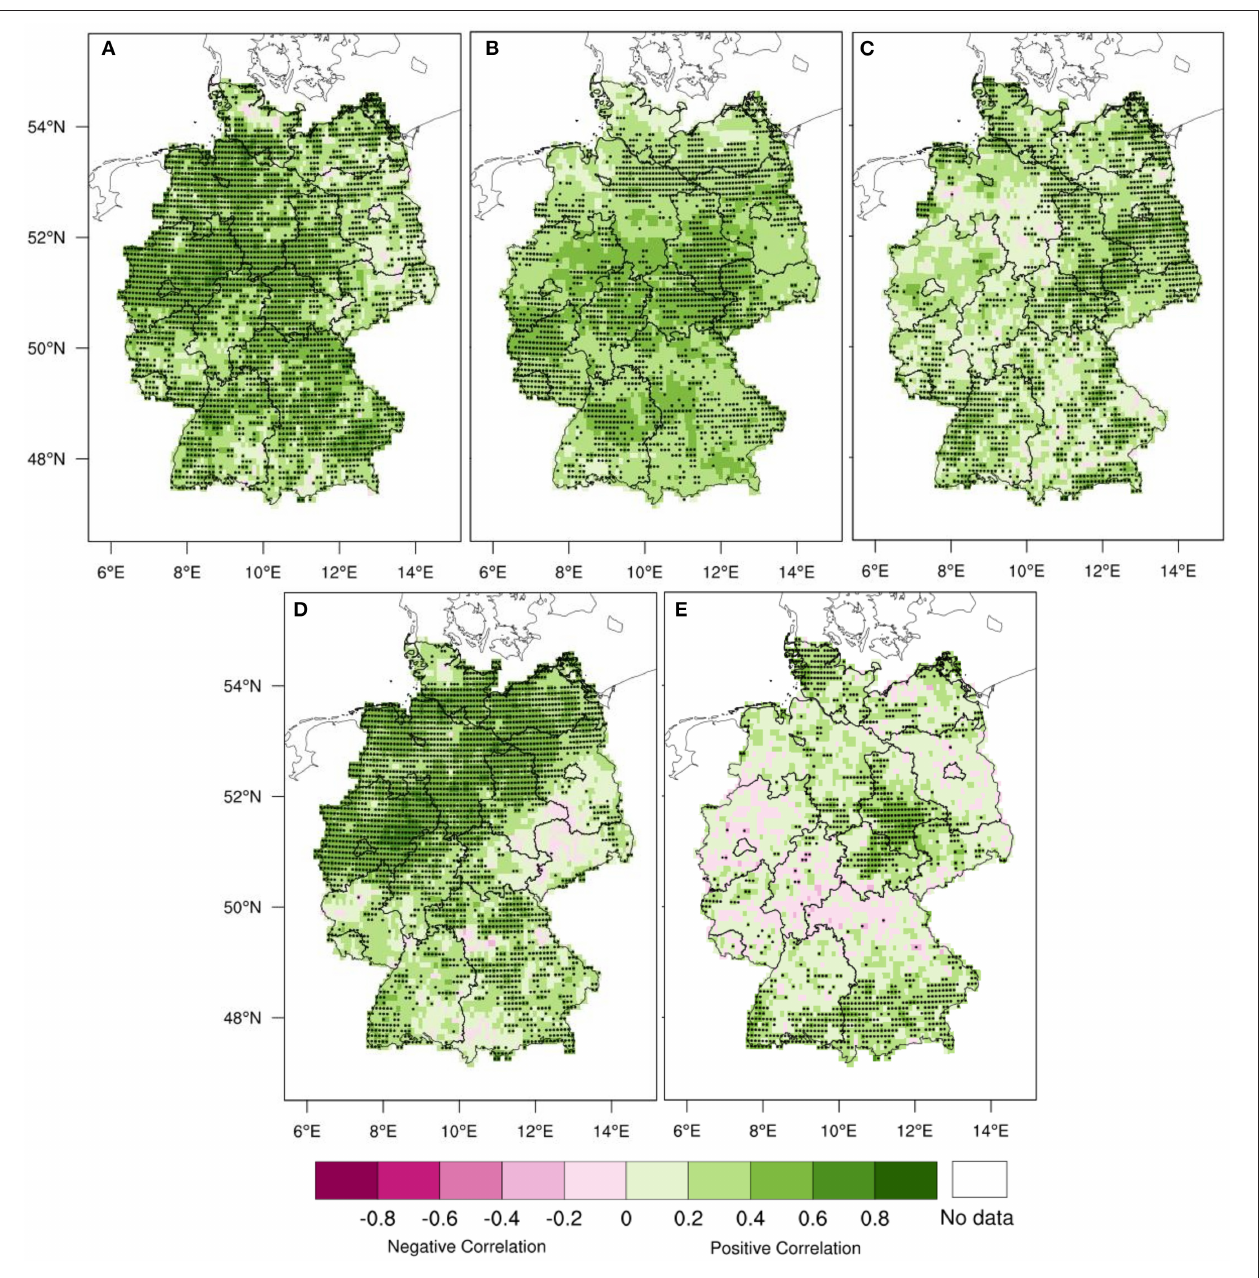
FIGURE 4 | Decadal prediction skill for 3-year SPI of January–December (A) , February–April (B) , May–July (C) , August–October (D) and November–January means (E) for forecast years 1–3 in the evaluation period 1962–2020 (1962–2019 for November–January): (Anomaly) correlation coefficient between EPISODES at optimized recalibration and HYRAS observations. Dots indicate significant skill (significance level of